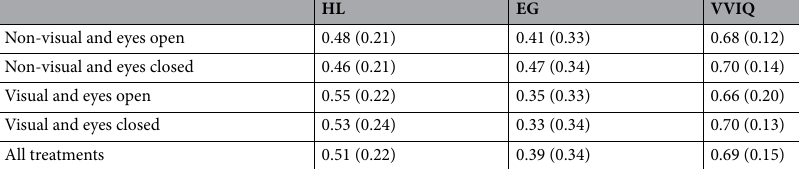
Table 2. Descriptive statistics. Mean values are reported with standard deviations in parentheses. The labels heading the columns refer to the variables elicited in Tasks 1–4, which are explained in the remainder of this section.